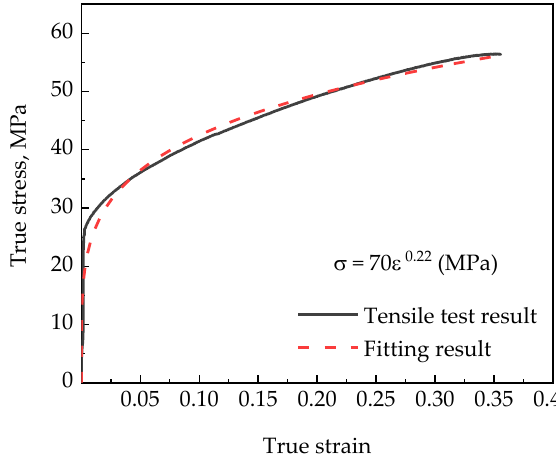
Figure 2. The true stress-true strain curve of 5N Aluminum obtained by quasi-static tension test and fitting by the power law hardening model: σ = A ε n .